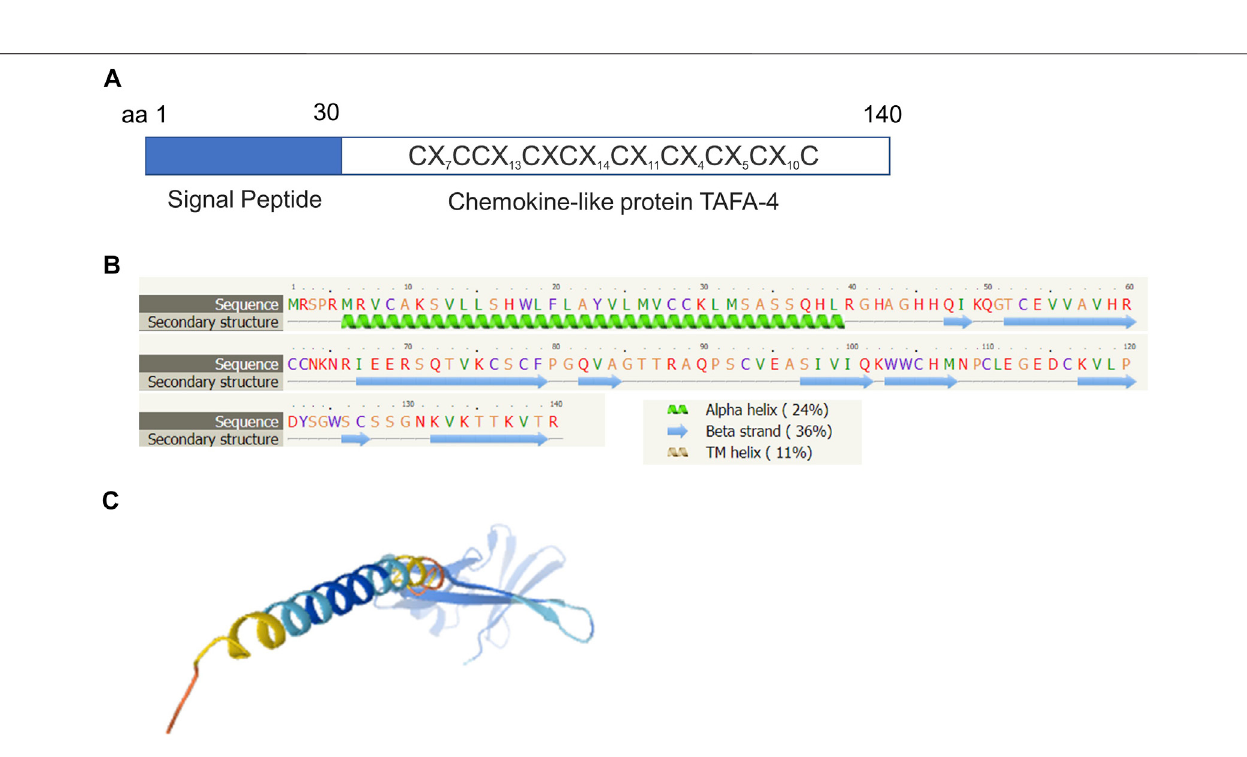
FIGURE 4 | Molecular structural analysis of TAFA4. Molecular structure ofTAFA4, predicted by bioinformatics information based on Uniprot (https://www.uniprot. org/), showing (A) a characteristic of a chemokine like ligand, (B) the Phyre2 web portal (http://www.sbg.bio.ic.ac.uk/phyre2/), and (C) AlphaFold web portal (https://